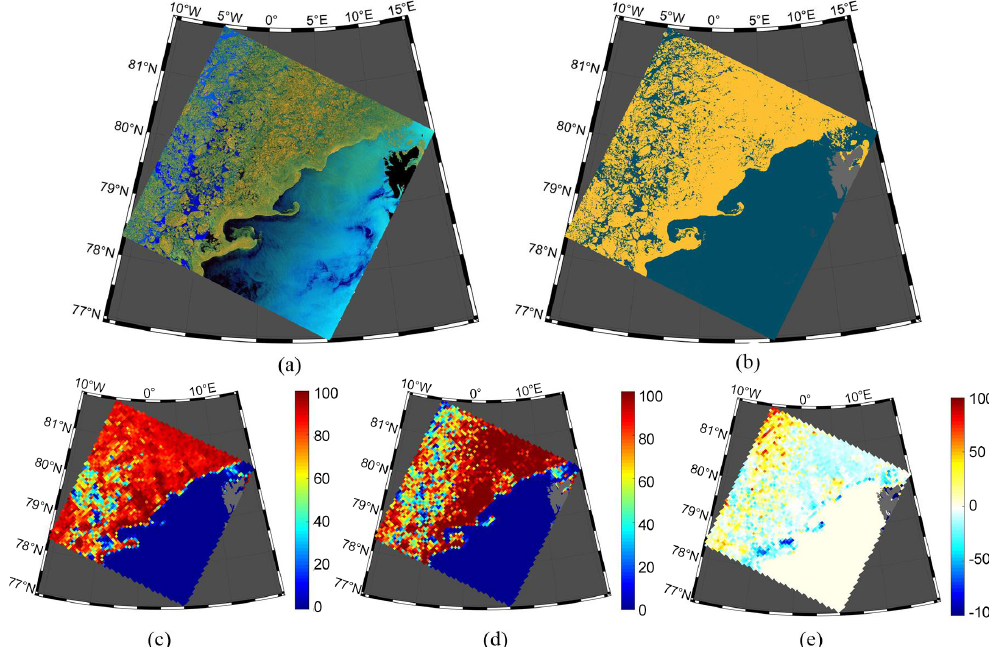
Figure 11. Example of S1-derived sea ice cover data and the comparison with the AMSR2 data. (a) RGB false-color composite image. (b) S1-derived sea ice cover result. Yellow indicates sea ice, cyan indicates open water, and gray indicates land. (c) Sea ice concentration based on the S1-derived result. (d) AMSR2 sea ice concentration. (e) Differences in the sea ice concentration between the AMSR2 data and